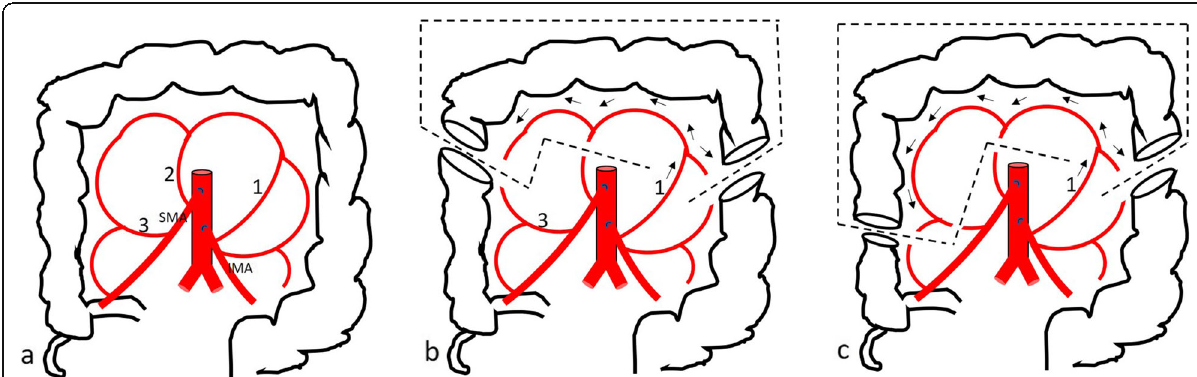
Fig. 1 Technique for fashioning an iso-peristaltic colonic flap including the transverse colon and based on the left colic vessels. a Vascular anatomy of the colon: superior mesenteric artery (SMA) giving origin for middle colic (2) and right colic arteries (3), while the inferior mesenteric artery (IMA) gives the left colic artery (1). b Boundaries of the colonic flap (dashed line) after ligation of the middle colic vessels. Note: ligation of middle colic vessels should be below its bifurcation to allow blood flow to the right side of the flap through the marginal vessels (arrows). c Extra length of colon can be included in the flap by extending ligation to the right colic vessels as